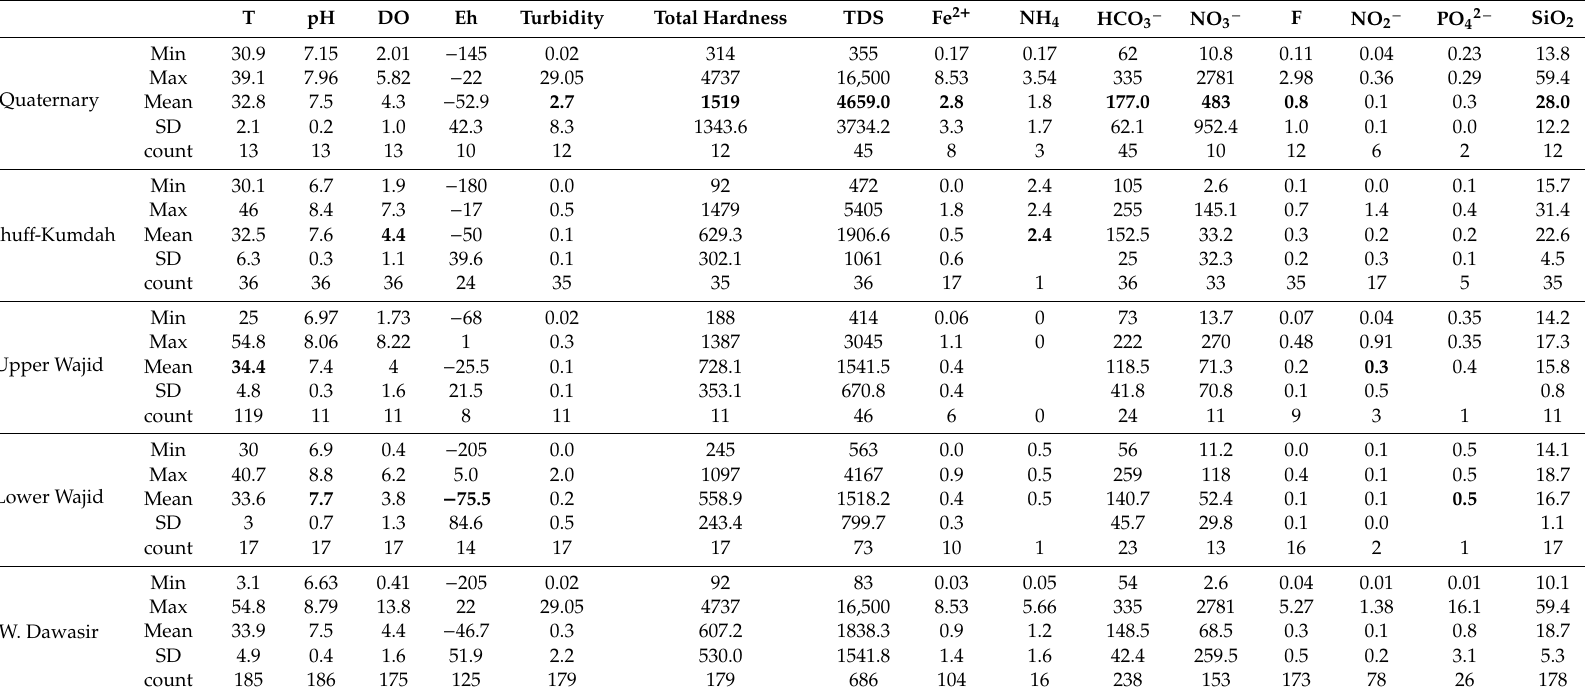
Table 1. Descriptive statistics of the groundwater quality indicators in Wadi